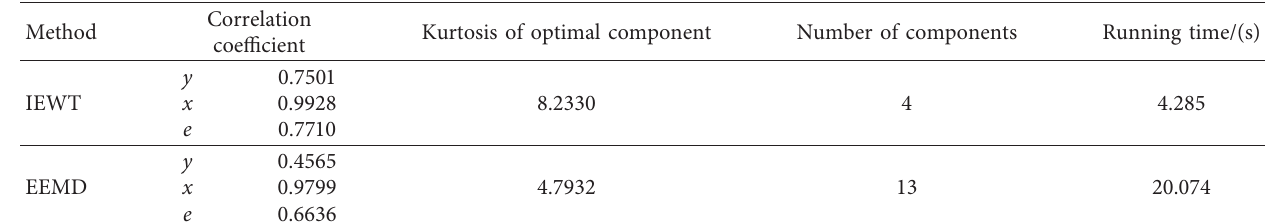
Table 5: Comparisons of IEWT and